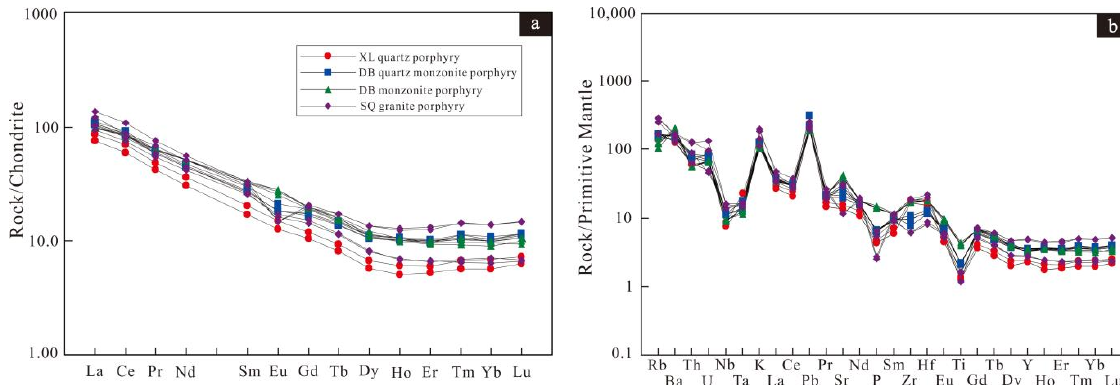
Figure 6. ( a ) Chondrite-normalized REE patterns, and ( b ) primitive mantle-normalized trace element spidergrams for the Early Cretaceous intrusive rocks in the study area. Chondrite-normalized and primitive mantle-normalized values are from Boynton [102] and Sun and McDonough [103], respectively.